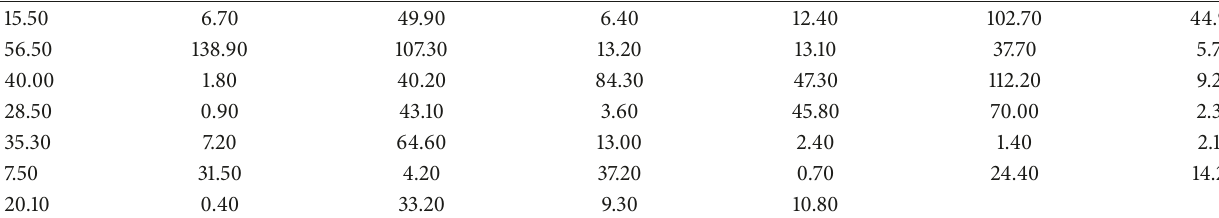
Table 1: Claims size 𝑥 𝑖 (millions Baht).